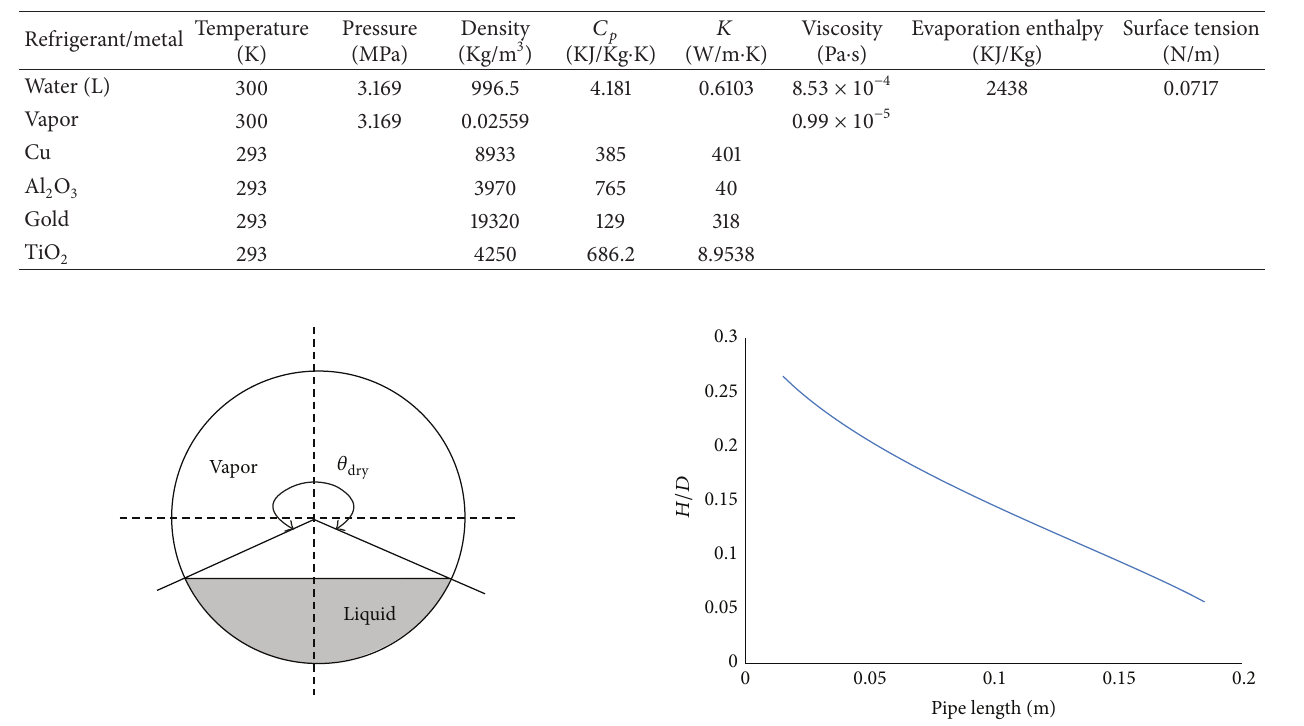
Figure 6: Schematic of dry angle for stratified flow regime in pipe.